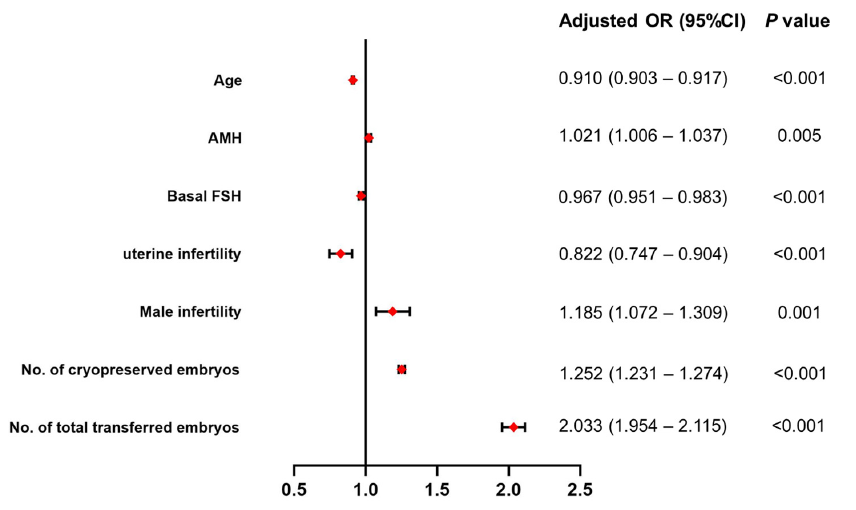
Figure 2. Forest plot of multivariable regression analyses. AMH: anti-Müllerian hormone; FSH: follicle-stimulating hormone. The red square is adjusted OR.